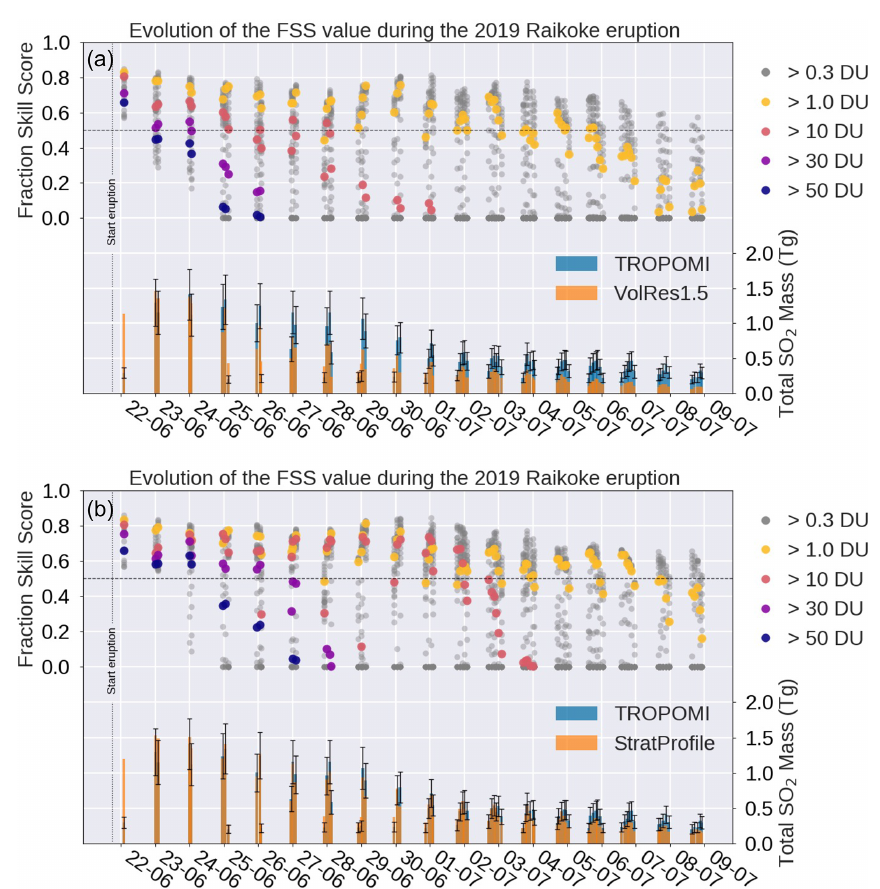
Figure 8. Time evolution of the FSS ( N = 1) and the SO 2 mass for each individual overpass of the TROPOMI satellite over the Raikoke cloud for (a) the VolRes1.5 simulation and (b) StratProfile simulation. Each annotated date represents 00:00UTC. Grey dots represent all concentrations between 0.3 and 100DU, with the highest skill score for the lowest concentrations. The horizontal dashed line shows a value of FSS = 0.5, which is the cut-off value for determining the skill of the